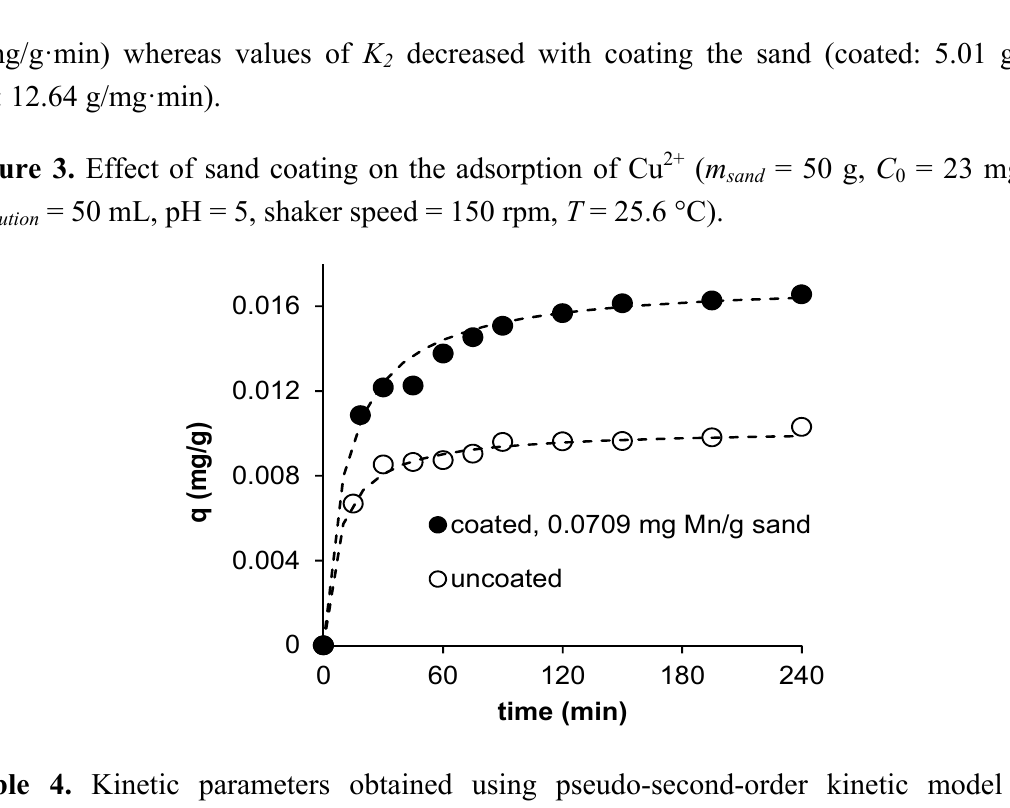
Figure 3. Effect of sand coating on the adsorption of Cu 2+ ( m